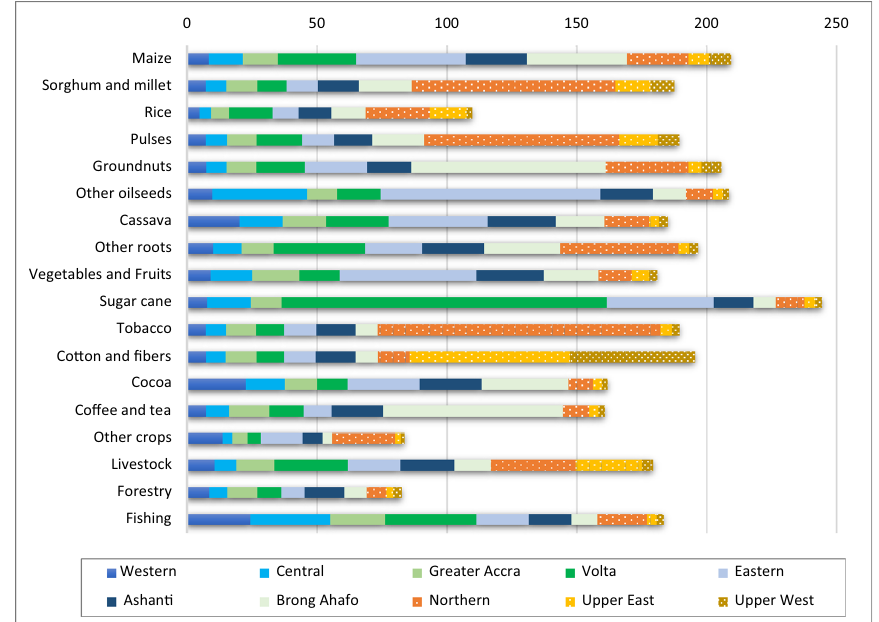
Fig. 2 Employment multipliers for primary sector in Ghana 2015 by region. Number of people jobs generated (by region) per million Ghanaian Cedis of output value (Source: author’s calculation based on Ghana SAM